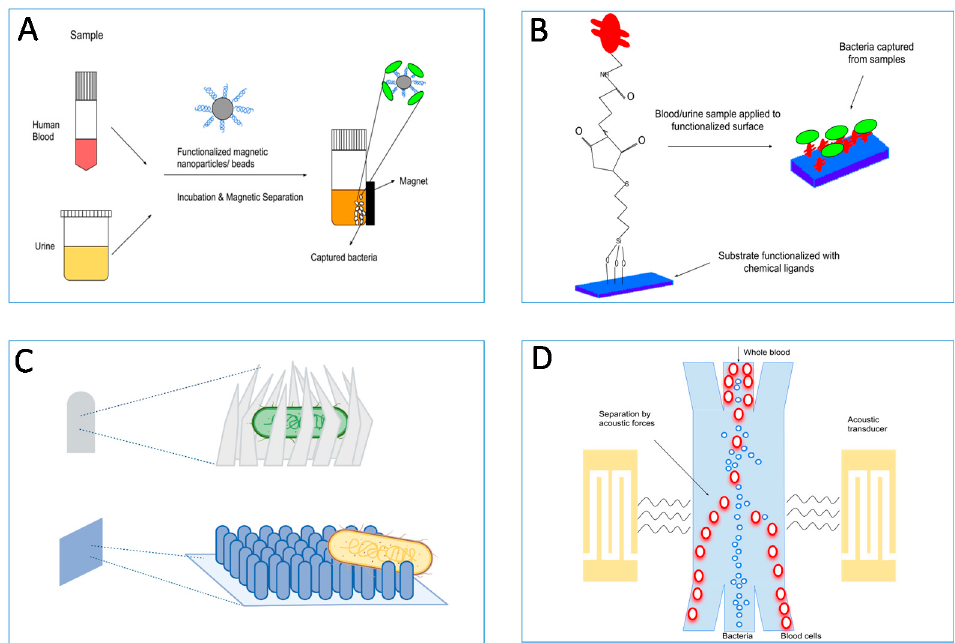
Figure 4. Adhesin–ligand interactions can be used to enrich pathogens from complex mixtures (e.g., fecal specimens, sputa, or urine samples) to a level where they would be clean and relatively easily detectable by classical tests. ( A ) Most common pre-enrichment methods make use of functionalized magnetic particles such as nanoparticles or beads, which bind to pathogens present in biological samples and are afterwards separated magnetically. ( B ) Surfaces functionalized with chemical cross-linkers and affinity ligands are used to directly capture bacteria with high specificity from biological samples. ( C ) Various types of nano-topographies such as prickly or nano-patterned surfaces, or nano-claws are used to capture bacteria. They are used alone or in combination with capture ligands. ( D ) Separation of bacteria from blood cells using surface acoustic waves in a microfluidic device. Other separation techniques such as viscoelastic separation are also used in microfluidic